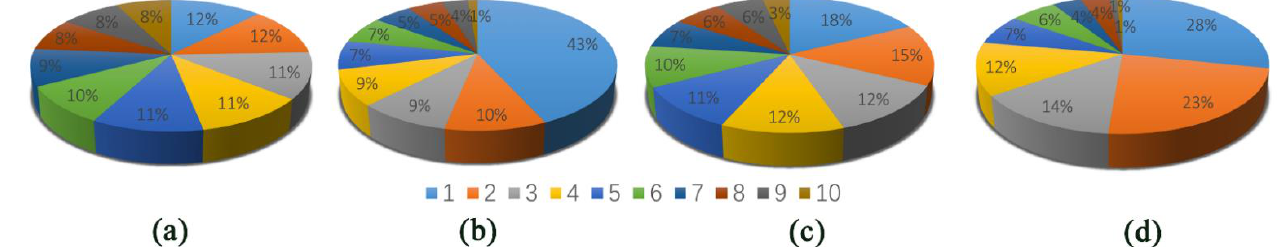
Figure 8. The cluster analysis for ( a ) Free-BRD4, ( b ) BRD4-Cpd4, ( c ) BRD4-Cpd9 and ( d ) BRD4- Cpd19.